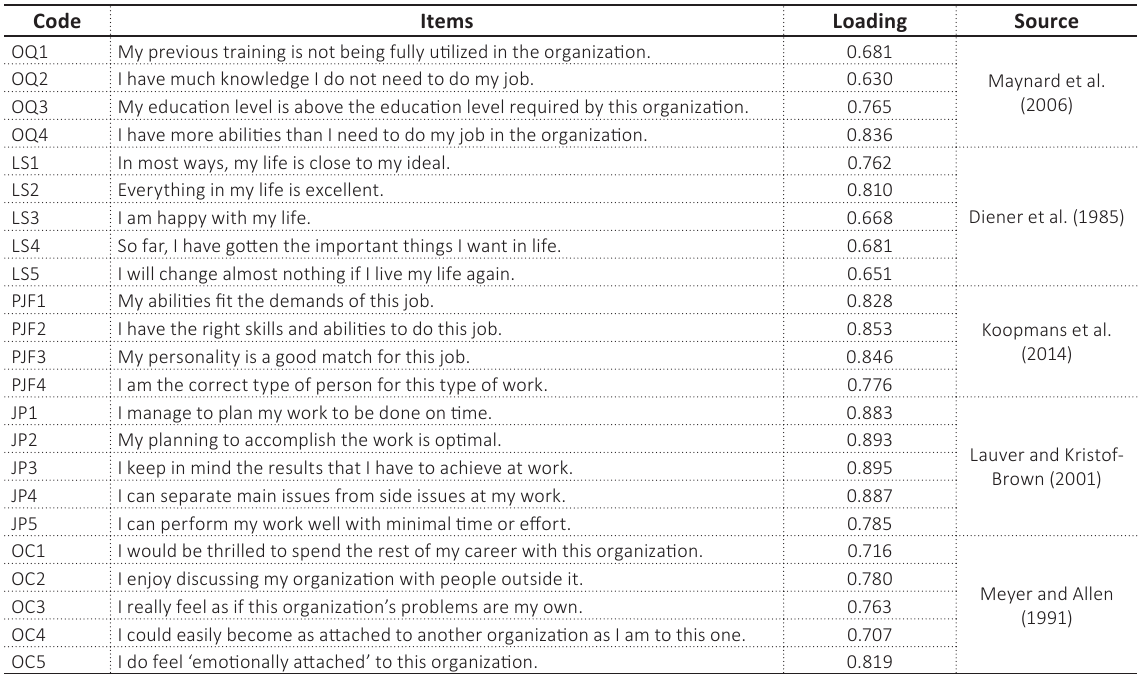
Table 2. Measurement items